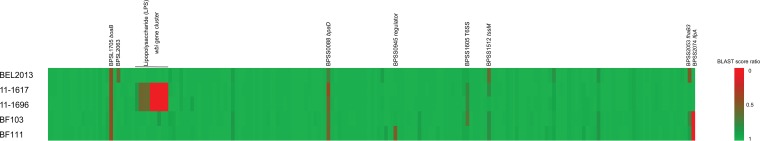
Blast score similarity ratios of all of the known virulence markers in B. pseudomallei K96243 compared to the African B. pseudomallei strains. African strains possess variable virulence gene contents, with trimeric autotransporter adhesions, LPS (wbi cluster), filamentous hemagglutinin (fhaB3), and lactonase family protein A (lfpA) all showing variability across strains.